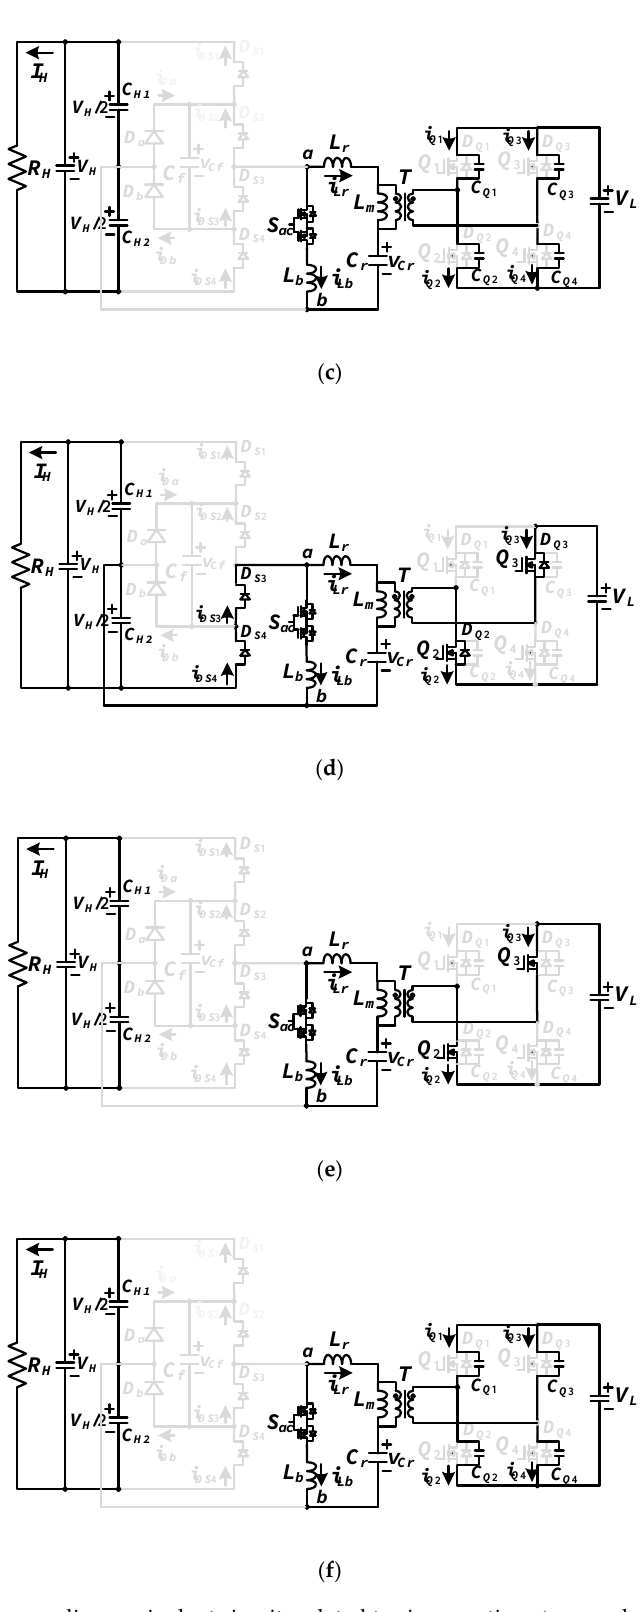
Figure 5. The corresponding equivalent circuits related to six operating steps under backward power transfer ( a ) step 1 circuit ( b ) step 2 circuit ( c ) step 3 circuit ( d ) step 4 circuit ( e ) step 5 circuit ( f ) step 6